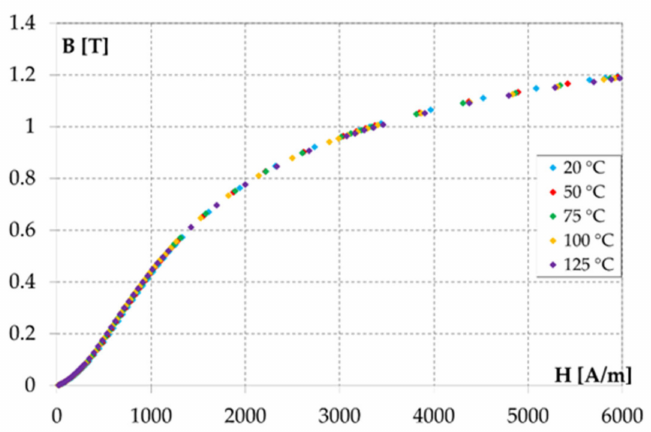
Figure 7. BH curves at different temperatures of SMC sample E 0.2-500.